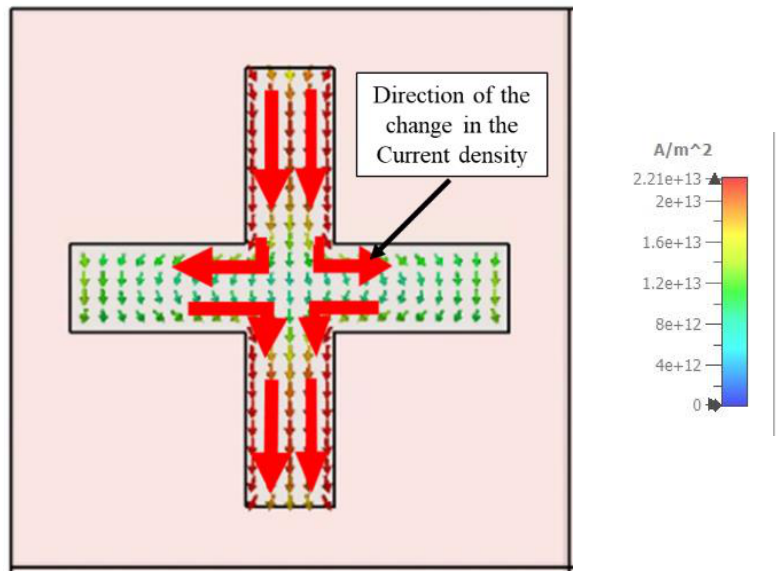
Figure 16. The current mode of the metal layer at 450 nm wavelength.